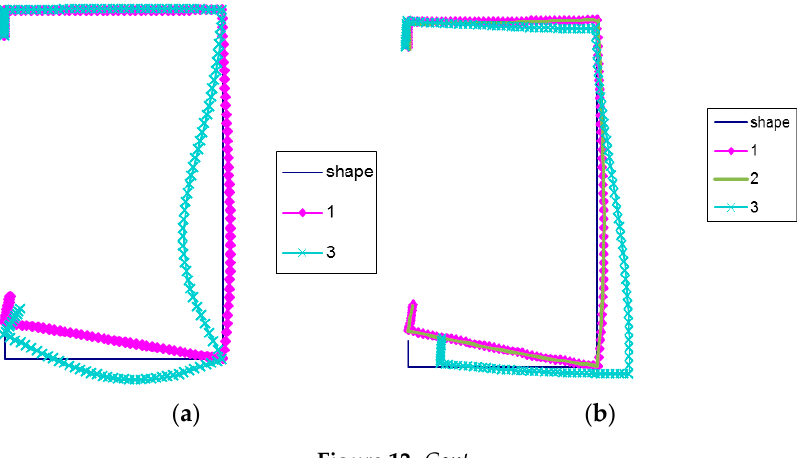
Figure 11. Buckling moments M r as a function of the buckling half-wavelength L b for